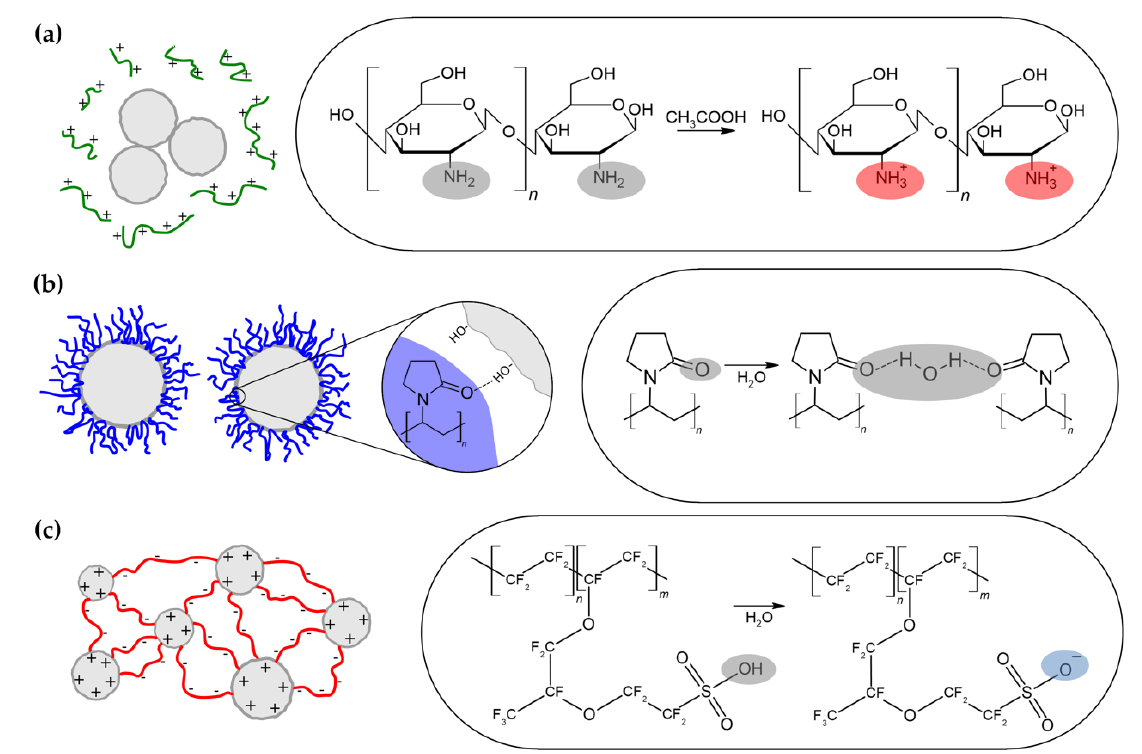
Figure 9. Characteristic suspension stabilization mechanisms exhibited by different polymers: ( a ) chitosan depleted electrostatic stabilization; ( b ) PVP steric stabilization; ( c ) Nafion electrosteric stabilization.